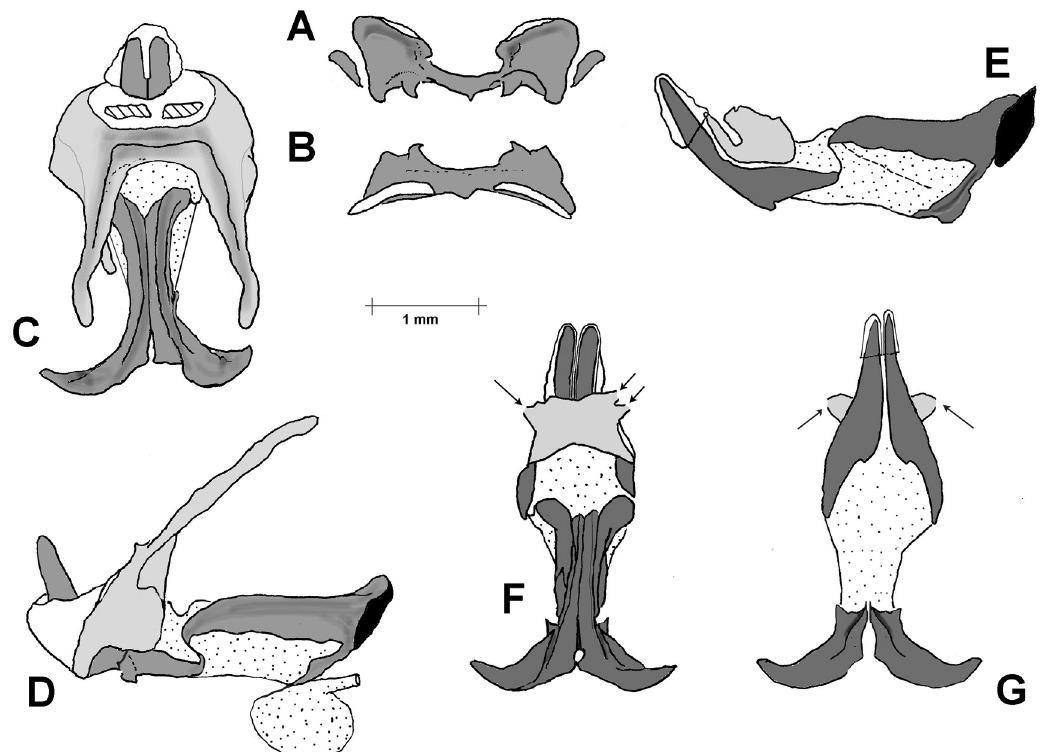
Fig. 8. Serpusia succursor , phallus. A. Epiphallus, axial view; B. Epiphallus, dorsal view. C. Phallic complex after removal of epiphallus and epiphallic membrane, dorsal view. The two cross hatched areas are the zones of attachment of the the arch to the inner surface of the zygoma; D. As in C, but lateral view; E. Endophallus and arch in lateral view; F. As in E but dorsal view. The arrows indicate cut margins of the arch where it has been freed from the inner surface of the zygoma; G. As F, but ventral view. In E, F and G the ejaculatory sac has been removed to show the detail of the gonopore